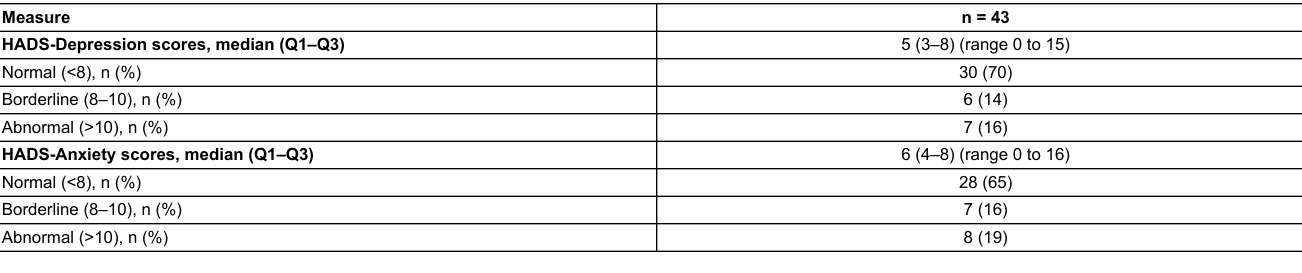
Table 4: Hospital Anxiety and Depression Scale ( HADS) scores at inclusion (n = 43).